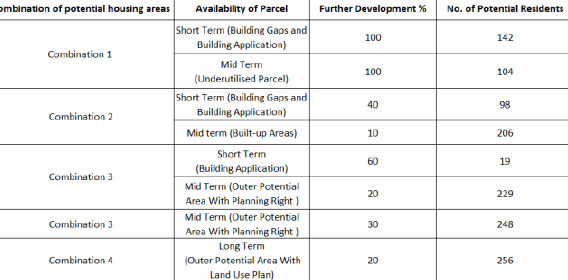
Table 1 : Combination of potential residential areas to meet need of prognosis